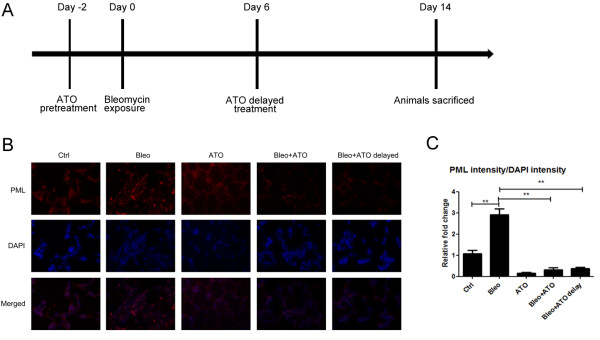
Daily injection of ATO reduces PML body in C57BL/6 mouse lungs. (A) Bleomycin (2units/kg) and ATO (1 mg/kg) were administered to C57BL/6 mice (n = 7) as indicated. Bleomycin was administered by oropharyngeal aspiration. ATO was administered daily by intra-peritoneal injection. (B) Mice were sacrificed 14 days after bleomycin administration. Bleomycin induced PML body formation, while ATO disrupted their formation, in mouse lungs. (C) Densitometric quantification of PML body intensity for Figure 5B. *P value < 0.05, **P value <0.01, ***P value < 0.001.